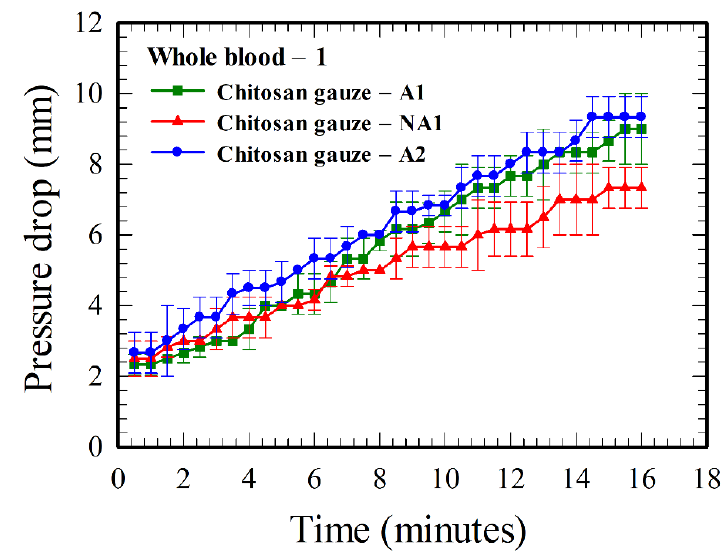
Figure 4. Time evolution of the pressure drops across various chitosan-based gauzes (refer to Table 1) for whole blood–1. Both A1 and A2 gauzes were acidified, while NA1 gauze was not. The base-weight of the A2 gauze is larger than that of the A1 gauze.